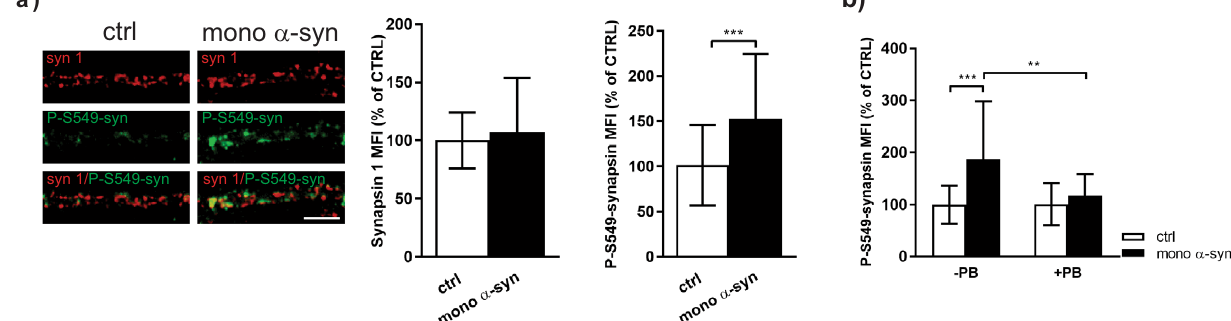
Fig. 6 Exogenous α -synuclein regulates presynaptic activity by interfering with MAPK and Calcineurin activity. a Representative images and statistical analysis of synapsin 1 (syn 1, red) and P-S549-synapsin (green) in primary cortical neurons treated with control solution (ctrl) or 500 nM of mono α -syn for 90 min. Number of analyzed cells: N = 25 ctrl cells; N = 33 mono α -syn-treated cells for synapsin 1 quanti fi cation (3 independent experiments); N = 36 ctrl and N = 46 mono α -syn-treated cells for P-S549-synapsin quanti fi cation (4 independent experiments). Within each experiment, values in treated cells are normalized to the mean value of the control group and expressed as mean ± SD. Statistical signi fi cance was evaluated using Mann – Whitney U -test. *** p < 0.001. Scale bar 5 µm. b P-S549-synapsin quanti fi cation in primary cortical neurons treated with control solution (ctrl) or 500 nM of mono α -syn in the absence or presence of ABCA1 transporter inhibitor Probucol (PB; 10 µM). Two-way ANOVA followed by Tukey ’ s post hoc test. Number of analyzed cells: N = 17 ctrl; N = 19 mono α -syn; N = 18 PB; N = 20 PB/mono α -syn. interaction F (1,70) = 5.25, p = 0.0249; mono α -syn F = 11.47, p = 0.0012; PB F = 4.92, p = 0.0297. ** p < 0.01 *** p < 0.001. Treatments were done at DIV 21 – 23. Scale bar 5 Preparation of α -syn488: The recombinant α -syn was marked with Alexa Fluor ™ 488 NHS-ester (A20000, Thermo Fisher Scienti fi c, Waltham, MA, USA) according to the manufacturer protocol.